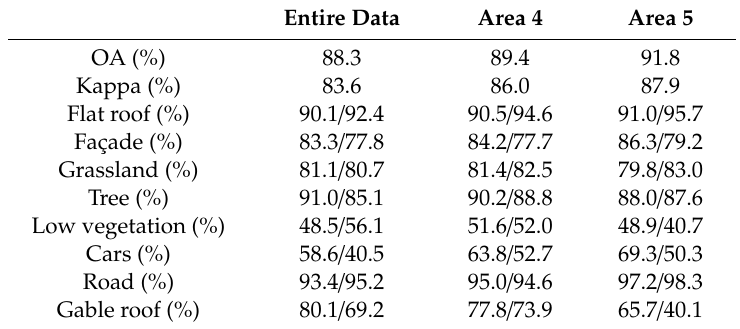
Table 6. Validation results of Toronto data set: completeness, correctness, overall accuracy and